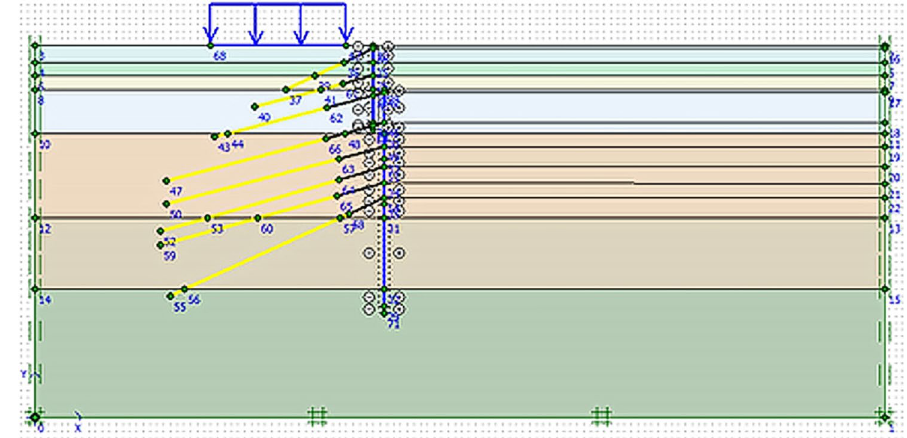
Figure 6. Calculation